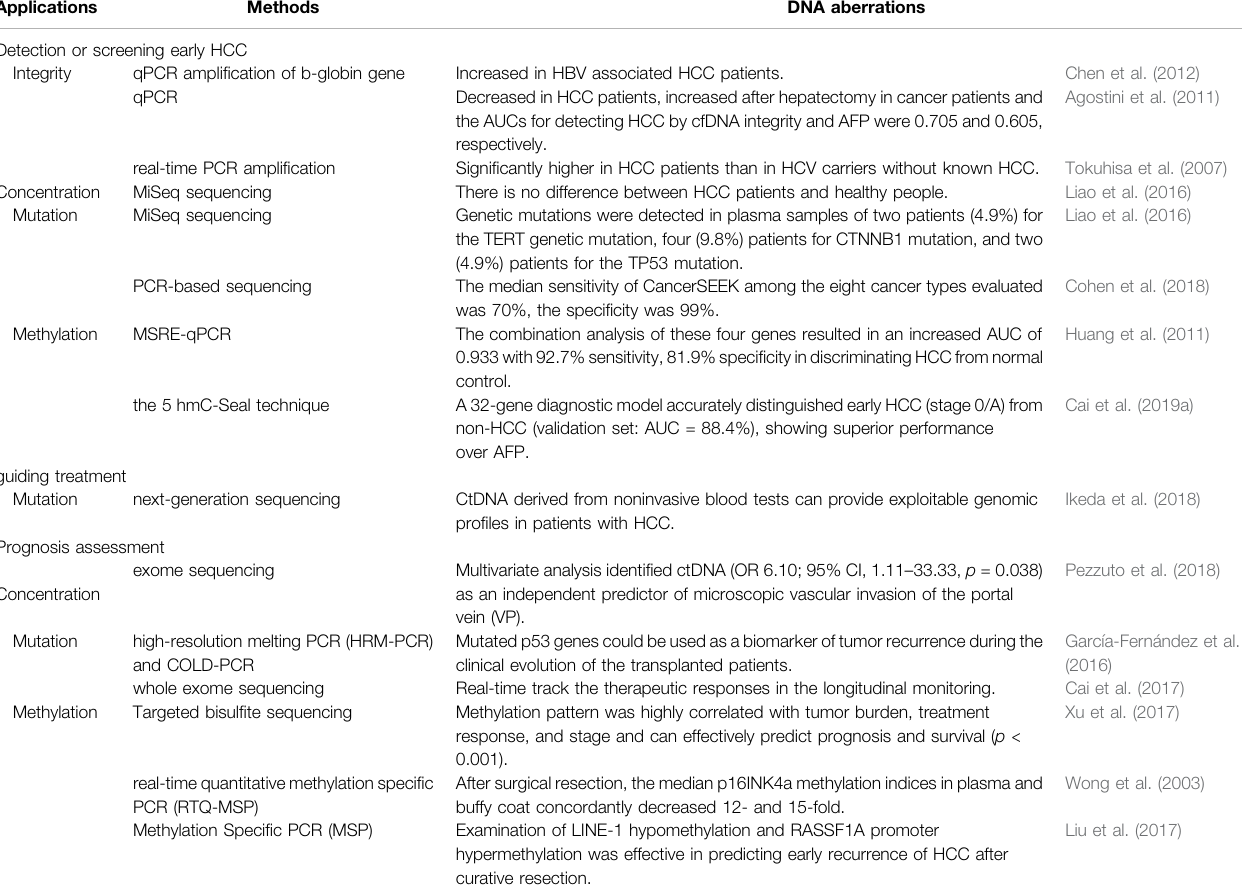
TABLE 1 | | Clinical Applications of cfDNA in